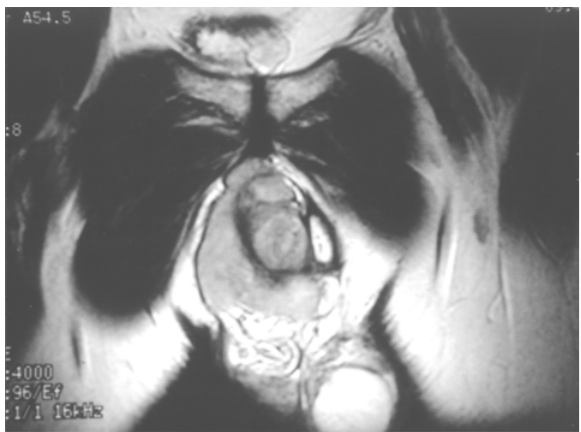
Figure 4 – Magnetic resonance imaging. Coronal T1-weighted image shows tumor in soft tissues affecting the root of the right cavernous body and extending to the pubis.